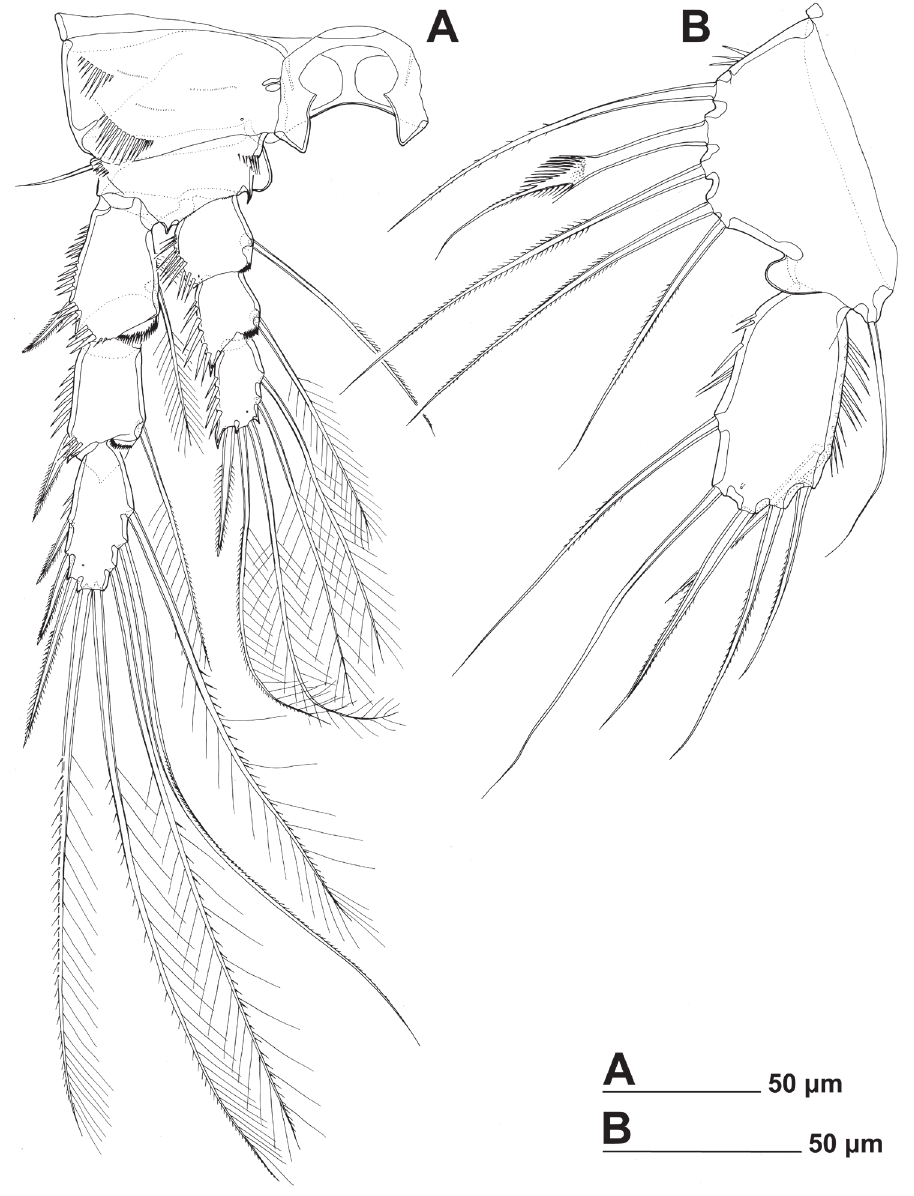
Figure 7. Stenhelia pubescens Chislenko, 1978, line drawings, female 3: A fourth leg, anterior B fifth leg, dissected and flattened,